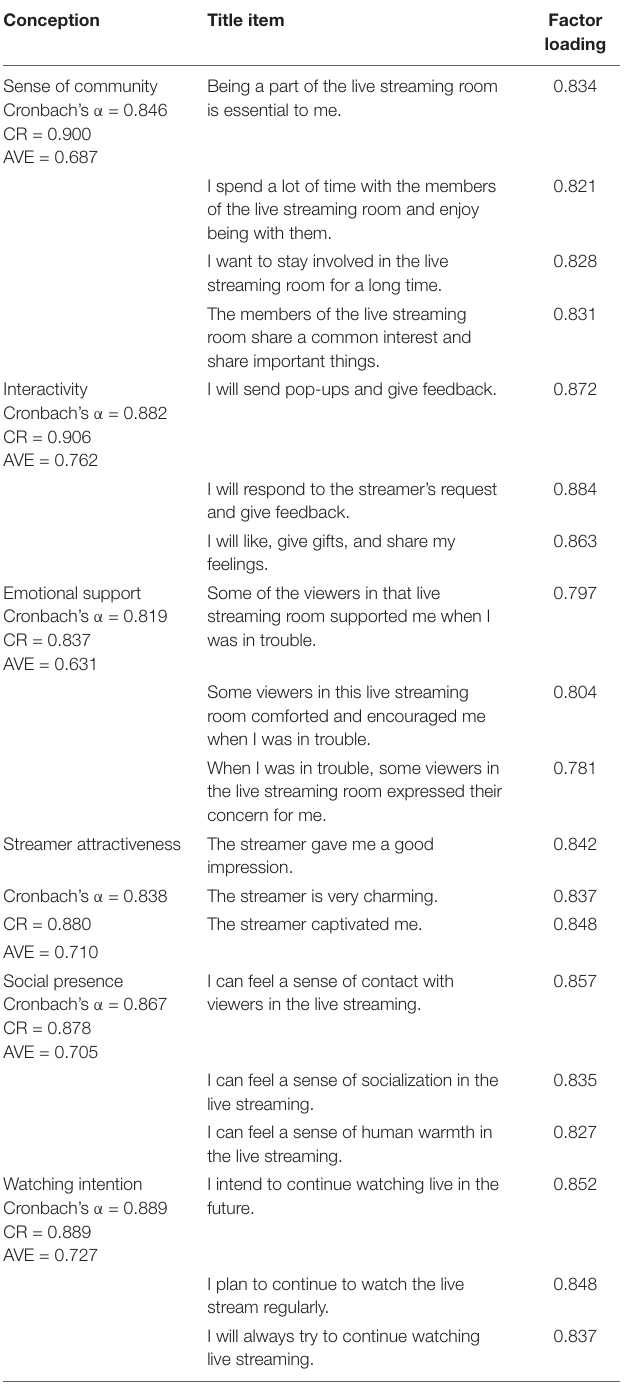
TABLE 2 | Results of confirmatory factor analysis. TABLE 3 | Result of multicollinearity test (VIF).